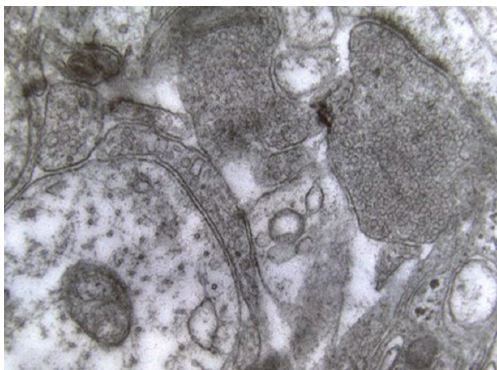
Figure 2: Mossy fibers of the cerebellar cortex in a case of Alz- heimer’s disease showing decrease of the number of the synaptic vesicles and lack of mitochondria (mag. 65.000x).